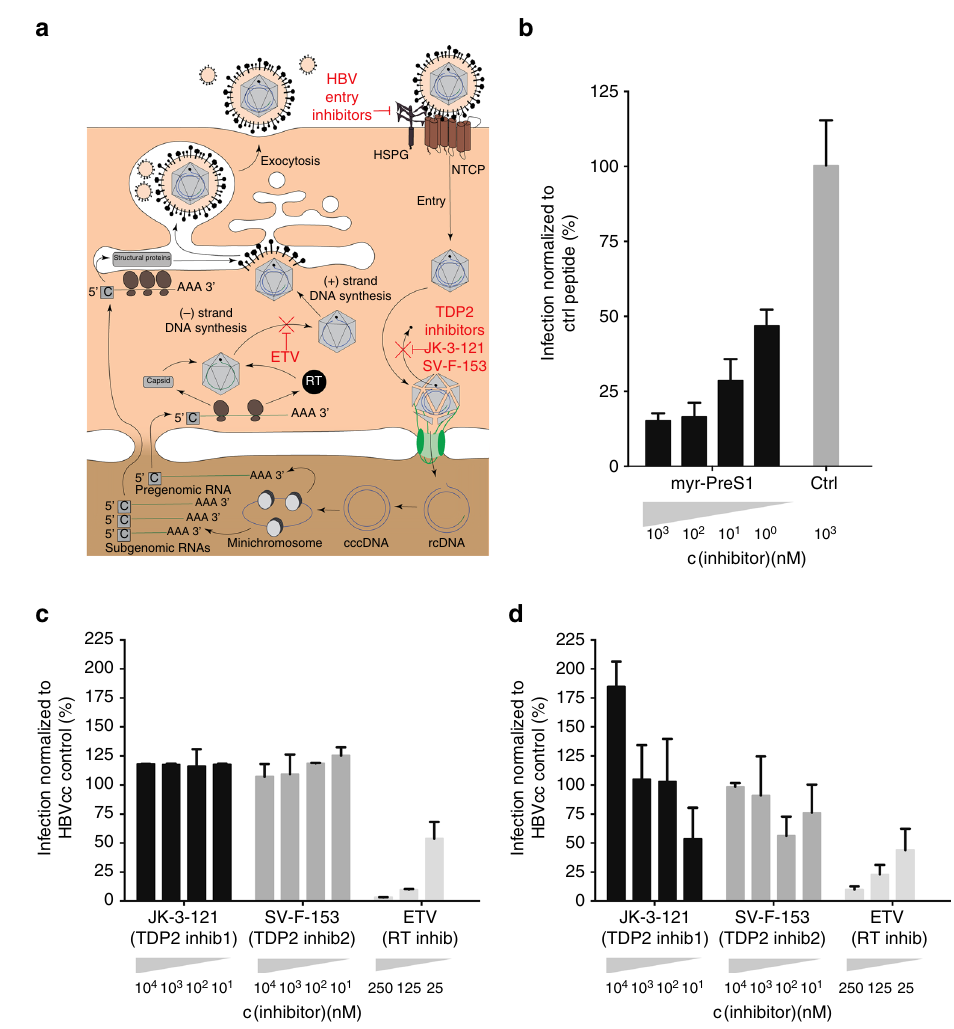
Fig. 5 Utility of SACC-PHHs for antiviral drug testing. a Schematic of HBV life cycle indicating the presumed mechanism of action of myr-PreS1 entry inhibitor, TDP2 inhibitors and ETV. b Prophylactic treatment with myr-preS1-derived peptides in SACC-PHH 96-well format (HU1007 mixed donor). Prophylactic c and therapeutic d drug dosing of SACC-PHHs (mixed donor HU1008) in 96-well format for nucleotide analog ETV and TDP2 inhibitors (JK-3-121, SV-F-153), x -axis: concentration of different drugs. y -axis: amount of HBsAg secretion normalized to that secreted by HBVcc infected untreated control cells. For HBVcc infections and drug treatments, six biological replicates were performed. All data are presented as means ±